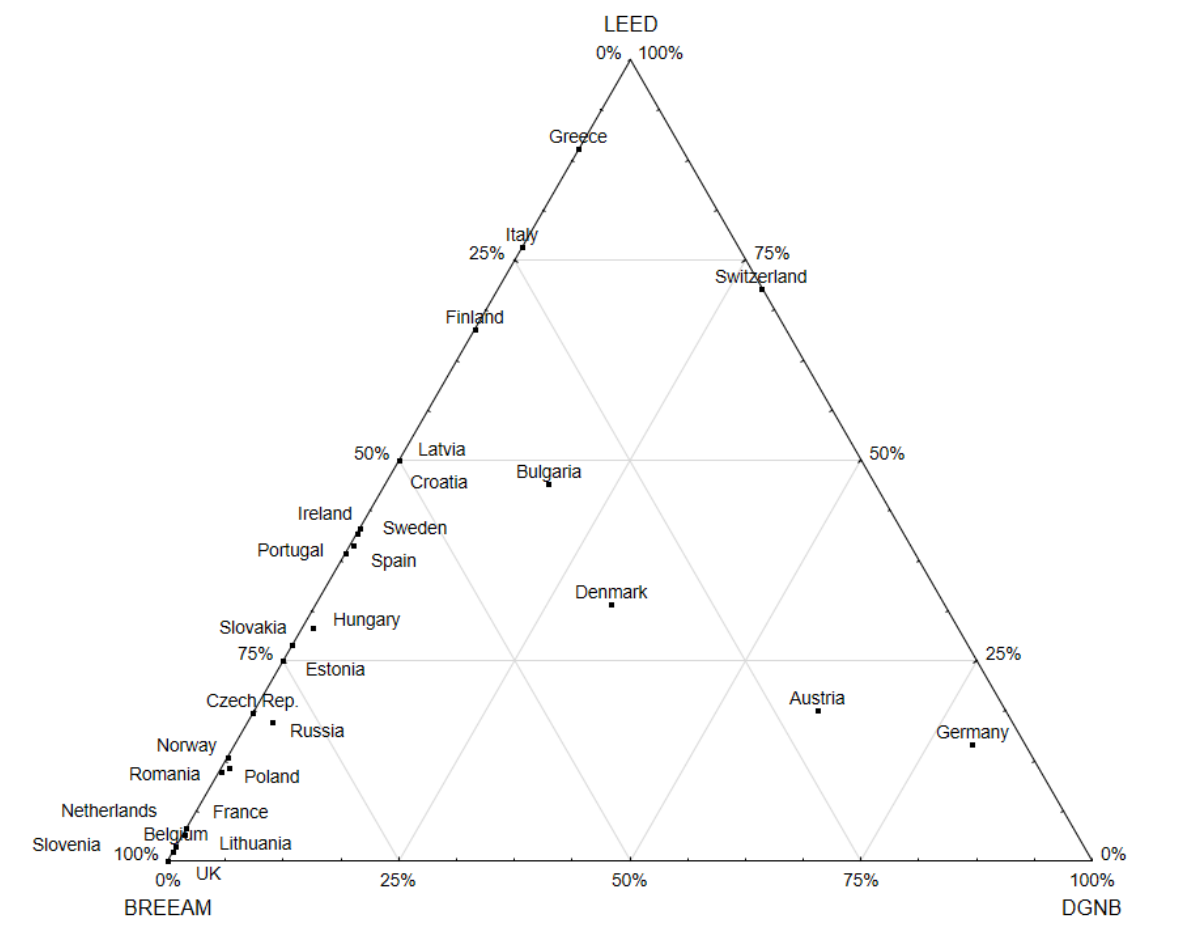
Figure 2. The competitive position of major green buildings certification systems in Europe in 2015.